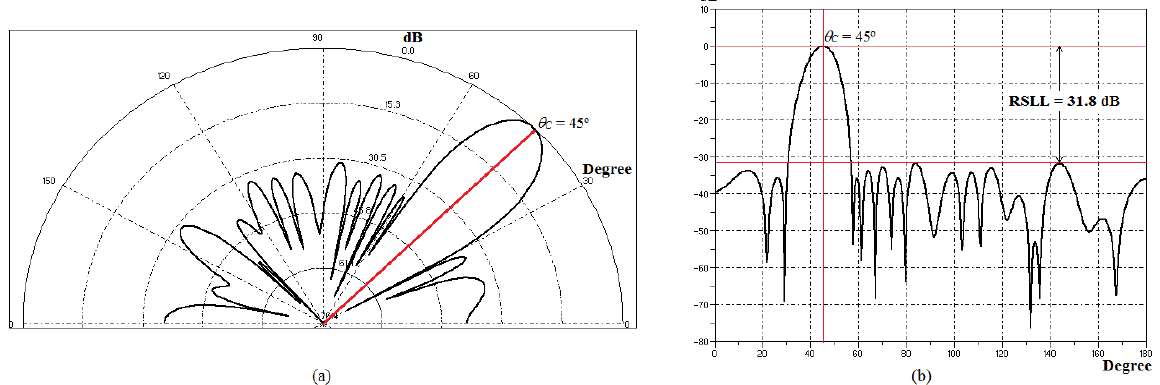
= 45 o in Table 2. ( a ) Polar form. ( b ) Cartesian 0